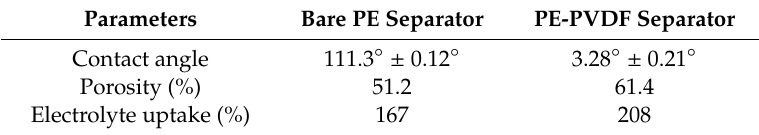
Figure 5. Contact angle photographs of ( a ) bare PE separator; ( b ) PE-PVDF separator. Table 3. Porosity, electrolyte uptake and contact of separator samples.